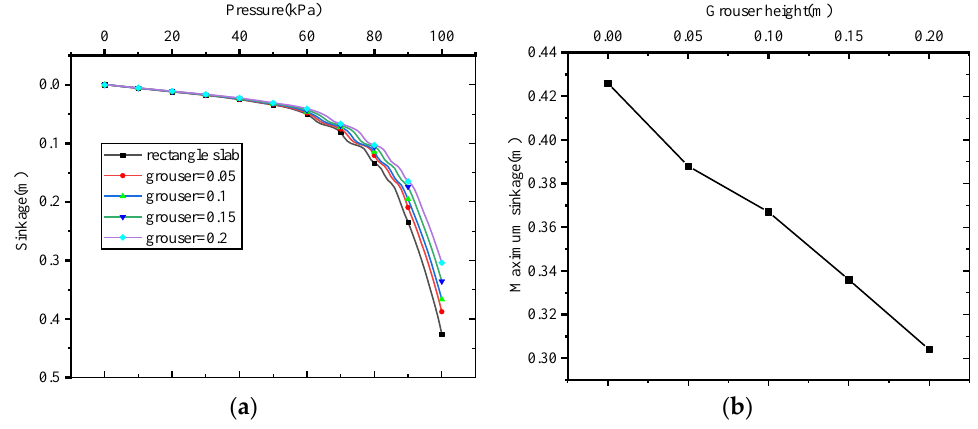
Figure 23. ( a ) Pressure-sinkage curves and ( b ) maximum sinkage at different grousers at 100 kPa case.